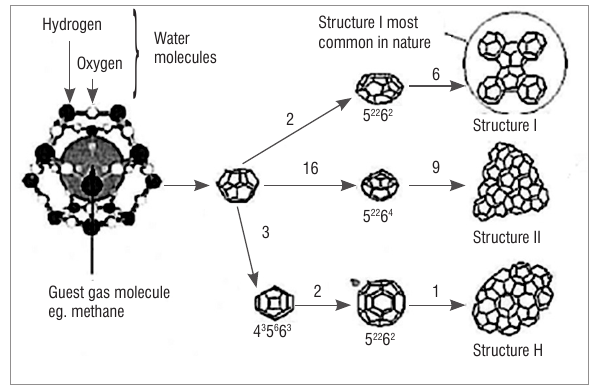
Figure 12: Guest molecule trapped inside water molecule, forming hydrates. 39